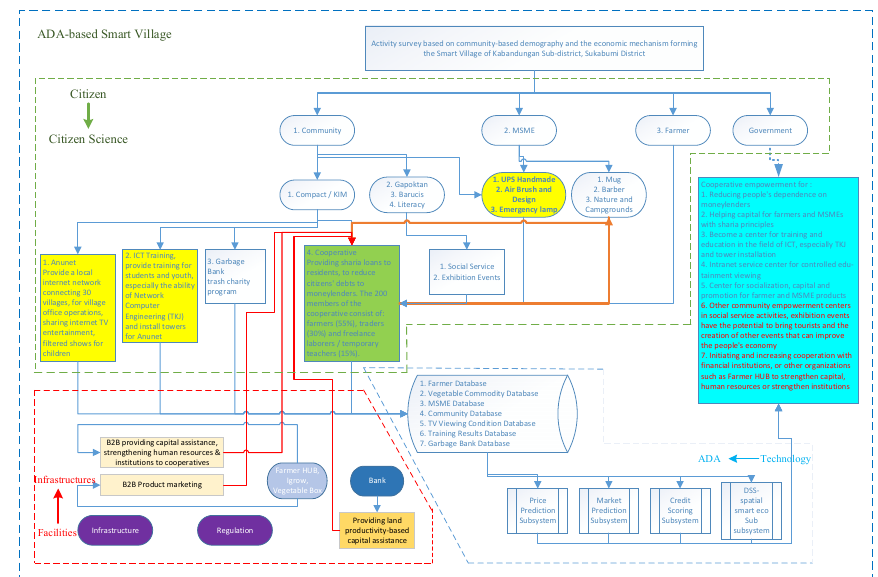
Fig. 6 . Strengthening citizen science for smart economy in smart village ecosystem in Kabandungan